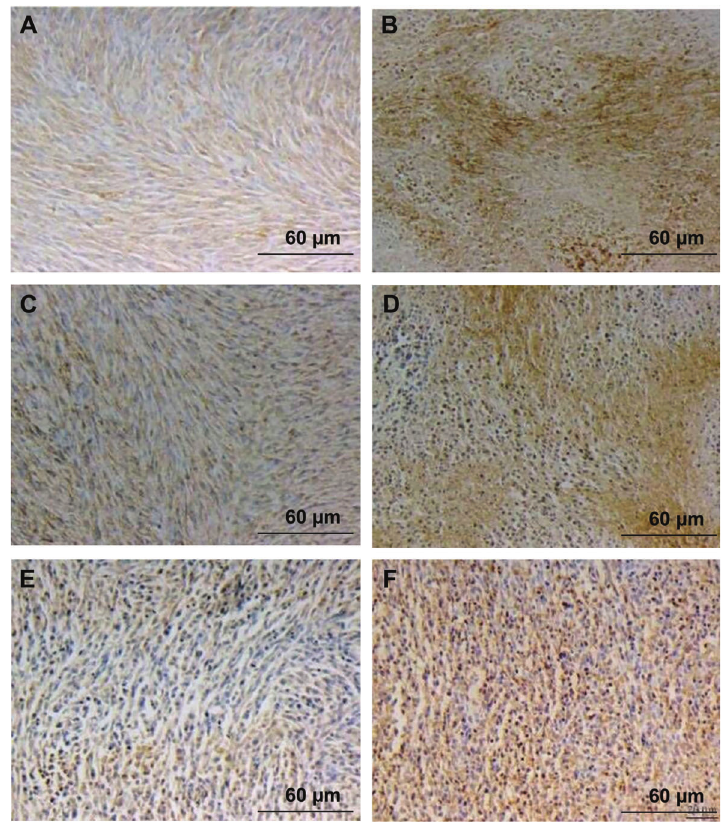
0.29 ± 0.04; t=6.50; P o 0.01; Figure 5B). Finally, type IV